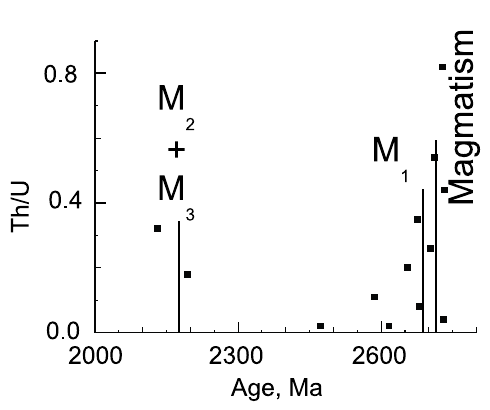
Fig. 4 –Age × Th/U diagram of zircons, sampleAL-1, showing a decrease in Th/U ratio from the magmatic ( ∼ 0 . 4) to the metamorphic ( ∼ 0 . 02) compositions. The 0.3 ratios near 2.1 Ga may be due to variation in fluid composition or physical